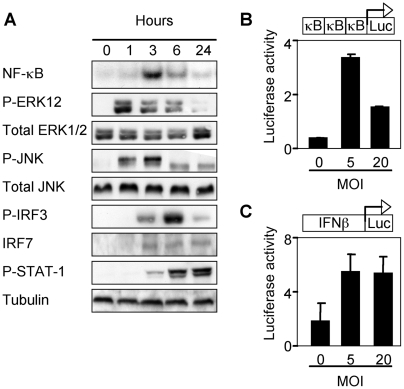
MVA activates the NF-κB, ERK1/2, JNK, IRF3, IRF7 and STAT-1 signalling pathways.Electrophoretic mobility shift assay of NF-κB DNA binding activity and Western blots of phosphorylated ERK1/2 (P-ERK1/2), JNK (P-JNK), IRF3 (P-IRF3) and STAT-1 (P-STAT-1) and total ERK1/2, JNK and IRF7 (A). Nuclear (NF-κB) and cytosolic (ERK1/2, JNK, IRF3, IRF7, STAT-1 and tubulin) extracts were prepared from THP-1 cells infected with MVA (MOI 5) for the indicated time. Results are representative of three independent experiments. The retarded complex detected by EMSA was dose-dependently inhibited by cold wild-type but not mutant NF-κB oligonucleotide, and supershifted using anti-p65 antibody (data not shown). NF-κB- (B) and IRF3- (C) mediated transcriptional activities measured in THP-1 cells transiently transfected with trimeric κB sites or IRF3-dependent IFNβ promoter luciferase reporter vectors and infected with MVA (MOI 5 and 20) for 18 h. Results are expressed as the ratio of luciferase activity to Renilla luciferase activity. Data are means±SD of triplicate samples from one experiment and are representative of four independent experiments. p = 0.05, 0.02, 0.04 and 0.02 for MVA-infected (MOI 5 and 20) vs. control cells.